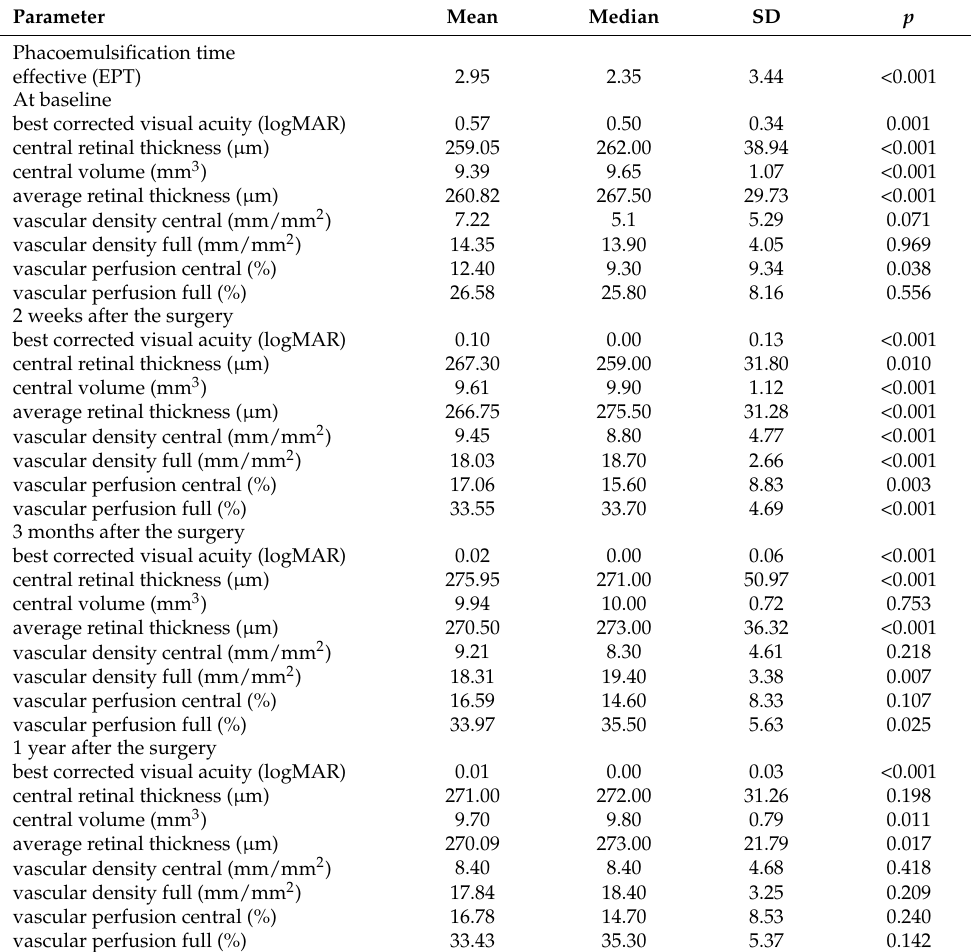
Table 1. Results for visual acuity, effective phacoemulsification time, and SD-OCT and OCTA measurements before and after the